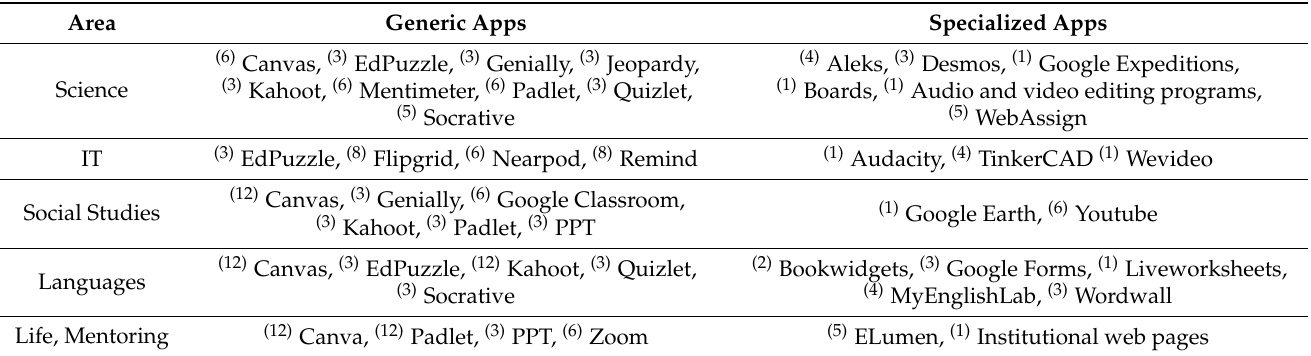
Table 1. Generic and specialty apps collected in the structured survey, questions (i), and (ii) mentioned in the Section 5.1. The super index in each app indicates the frequency of mentions according to the surveyed